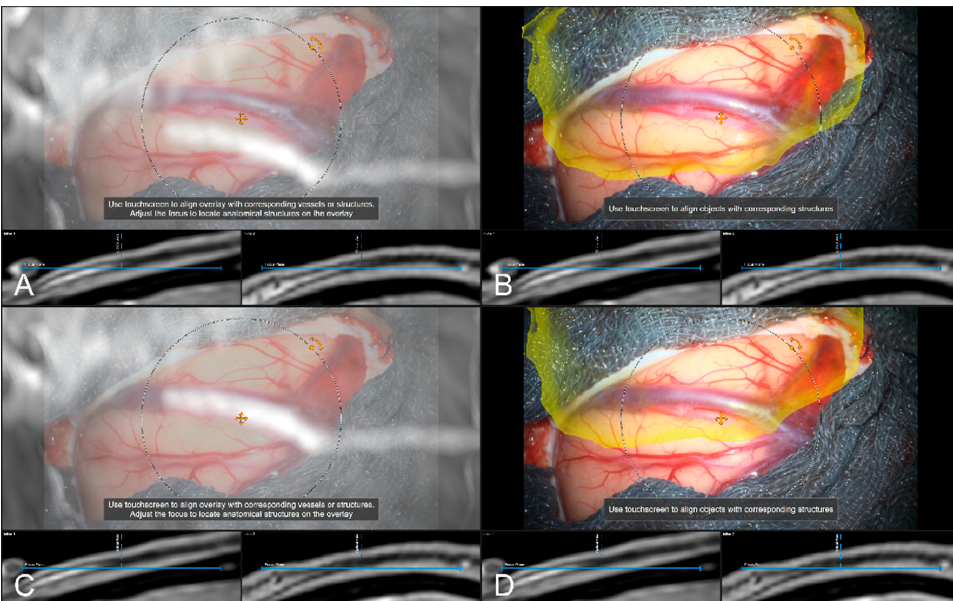
Figure 7. Navigation inaccuracy visualized in the recent focus plane utilizing a MIP of a preoperative T1-CE image showing the translational mismatch of MIP and patient anatomy ( A , B ) and the match of MIP and patients anatomy in the recent focus plane after manual correction (translation) of the visual misalignment ( C , D ). (In parallel view of MIP projection and patient anatomy (upper part) and inline views with the recent focus plane (blue line) and the optical axis (dashed blue line) in the bottom part).